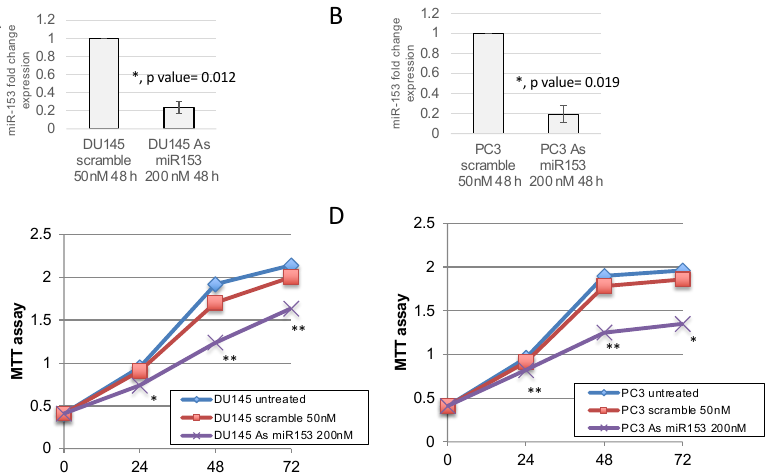
Figure 3. KLF5 is a putative target of miR-153. ( A ) Targetscan prediction revealed a single 8-mer highly conserved binding site of miR-153 on KLF5 ( A ) and two less conserved binding sites. ( B ) RT- qPCR analysis revealed in DU145 and PC3 that there is a downregulation of KLF5 mRNA expression (fold change expressed as 2 − ∆∆ CT ± sd values are shown; average of two independent experiments in triplicate; t test, p value ≤ 0.05, *; 0.01, **; 0.001, ***). ( C , E ). Modulation of miR-153 expression in DU145 (panel C ) and in PC3 (panel E ) calculated by RT-qPCR as fold change expression (2 − ∆∆ CT ± sd values) compared to scrambled-treated cells. ( D , F ) KLF5 expression in DU145 (panel D ) and in PC3 (panel F ) calculated by RT-qPCR as fold change expression (2 − ∆∆ CT ± sd values) compared to scrambled-treated cells. ( G , H ) Luciferase assay performed in DU145 ( G ) or in PC3 ( H ) cells in the presence of Scr, As miR-153 or S miR-153 oligonucleotides. t Test p values are indicated (calculated versus scr-treated cells).